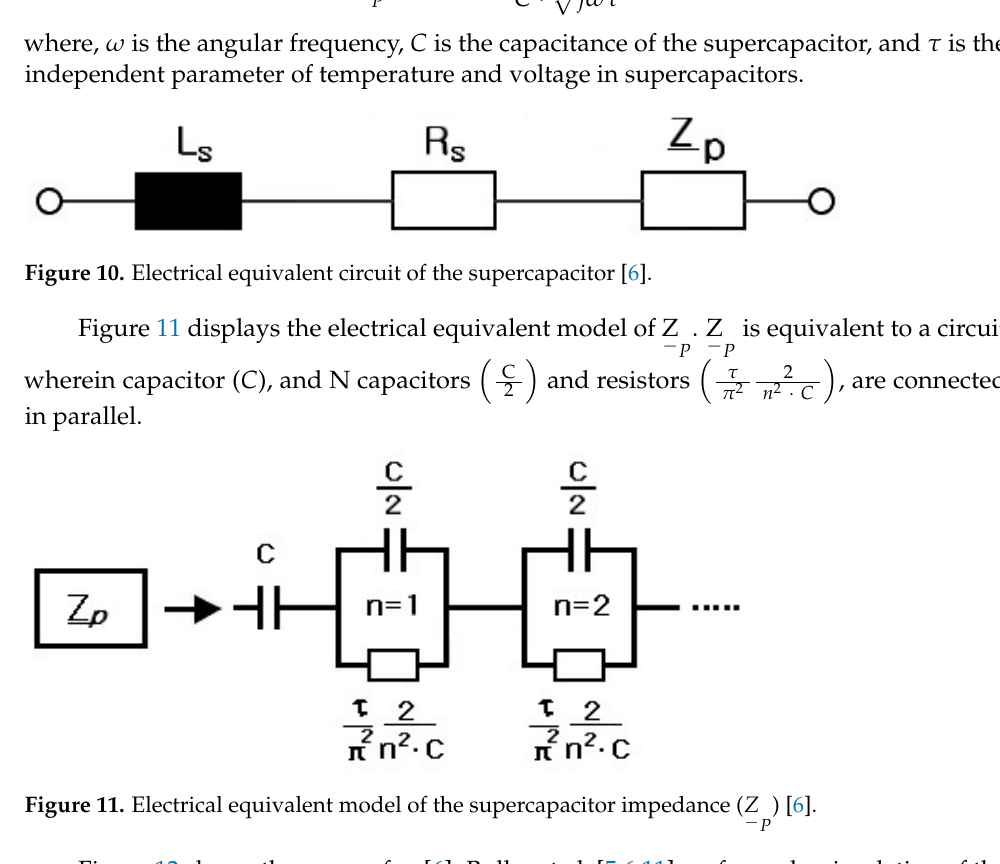
Figure 13. Theoretical model of the impedance spectrum of supercapacitors with porous elec- trodes [11].